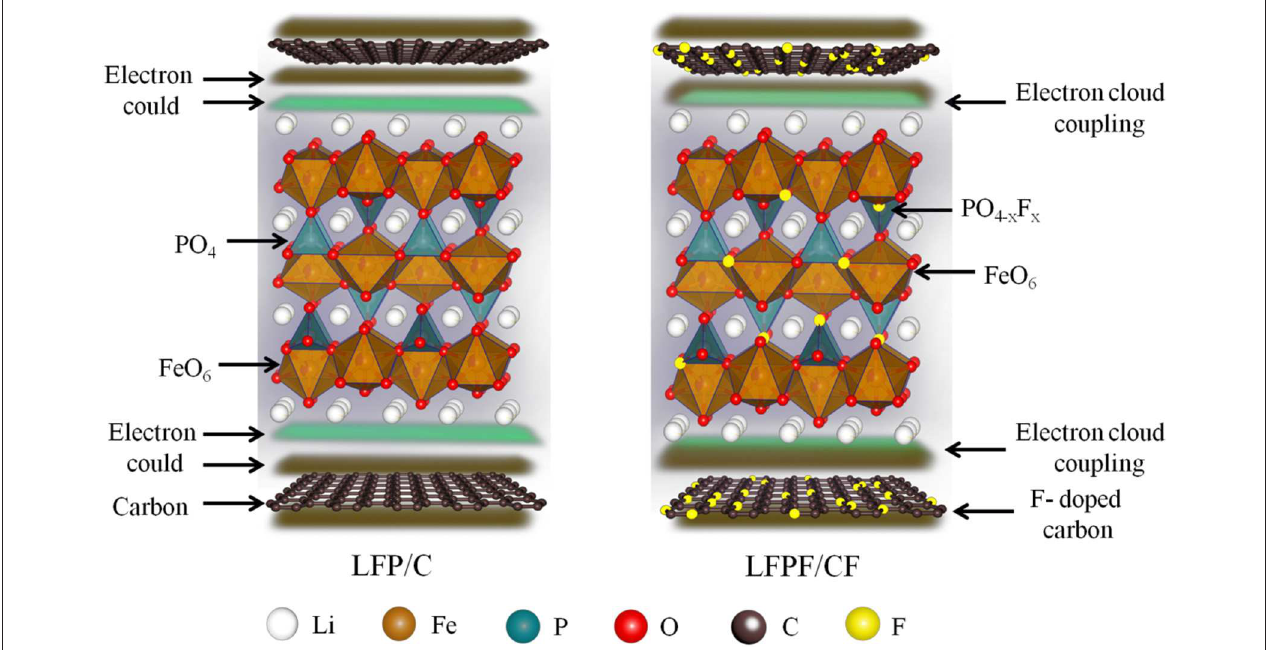
FIGURE 4 | Illustration of the strong interaction between LiFePO 4 − x F x and F-doped carbon.